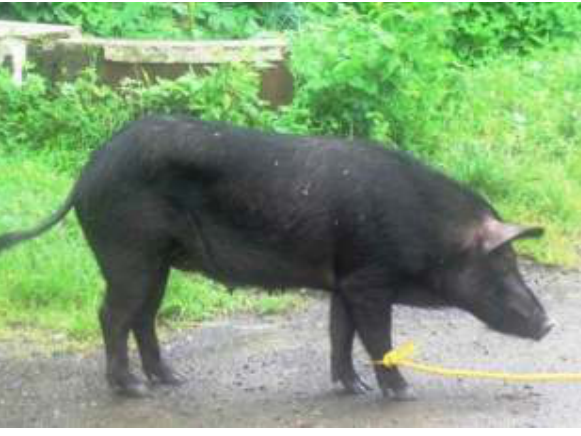
Figure-1. Andaman Desi pig Andaman wild pig, Nicobari pig, Andaman Desi